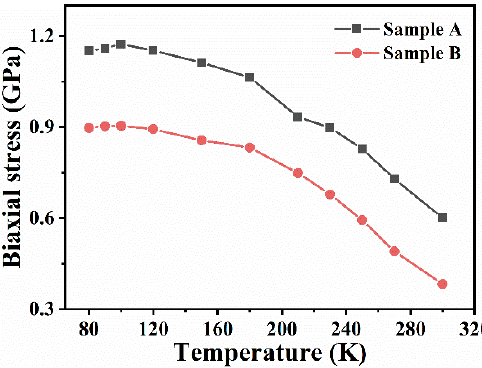
Figure 3 . The biaxial stress of AlN/sapphire films as a function of temperature from 80 K to 300 K.